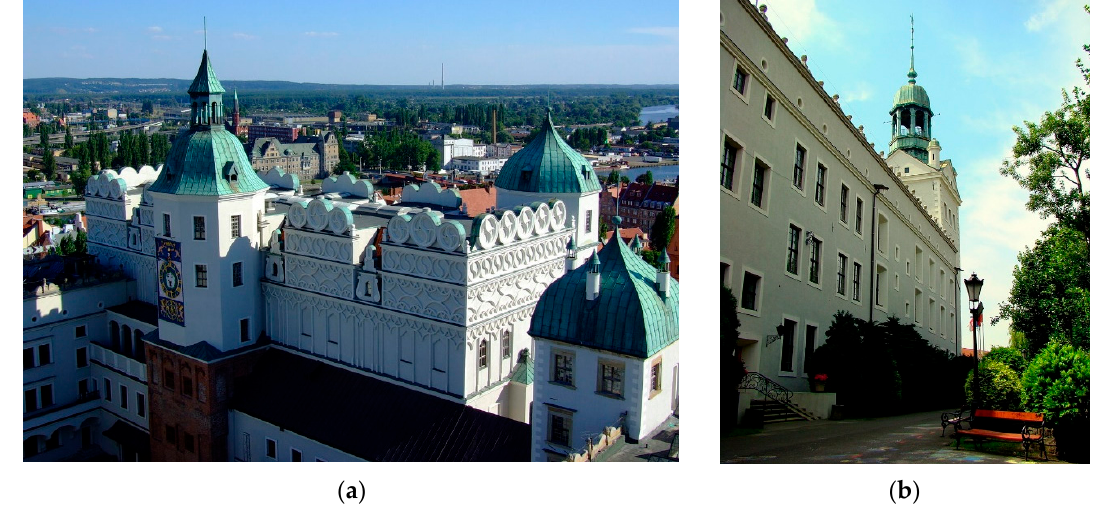
Figure 8. ( a ) The current shape of the south wing, public domain; ( b ) the current shape of the north wing, photo: Mateusz War., source: Wikimedia Commons.